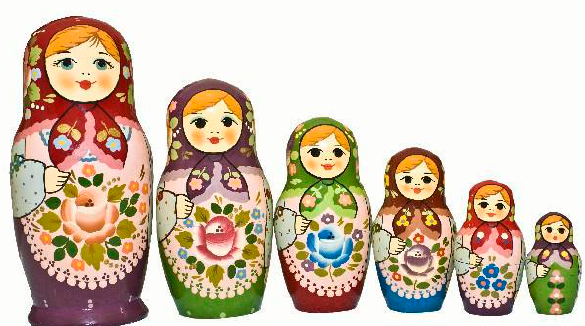
Figure 14. Matryoshka doll: The doll is composed of multiple hollow wooden dolls. As the calculation order is similar to the structure of the toy, the proposed algorithm was named the Matryoshka doll algorithm.